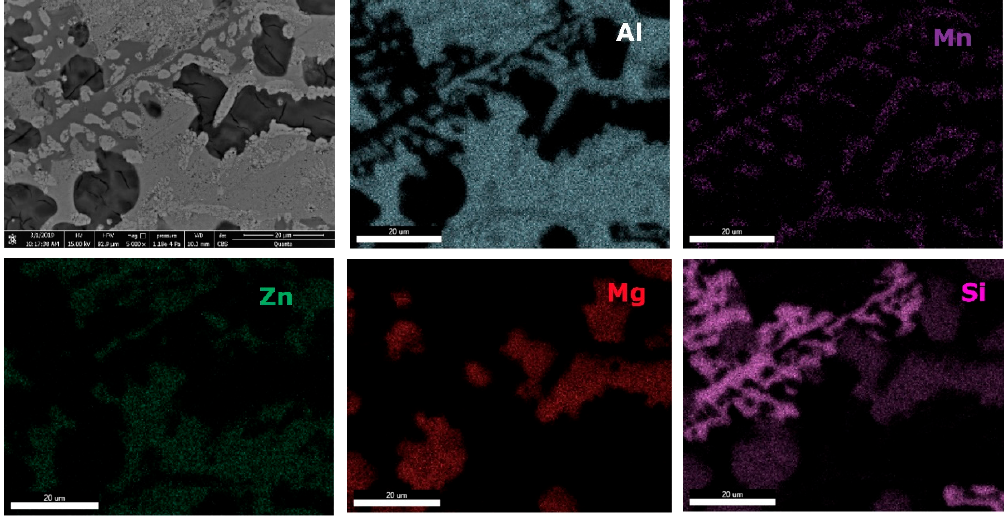
Figure 19. EDS mapping of heat treated Al 3 Mn 0.2 Zn 0.3 Mg 0.7 Si 0.8 alloy.